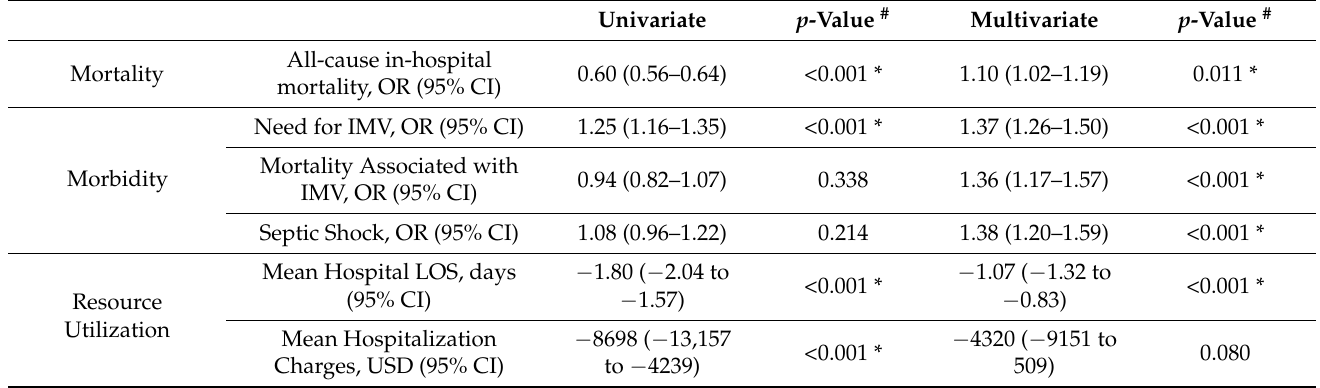
Table 3. Regression outcomes of obese